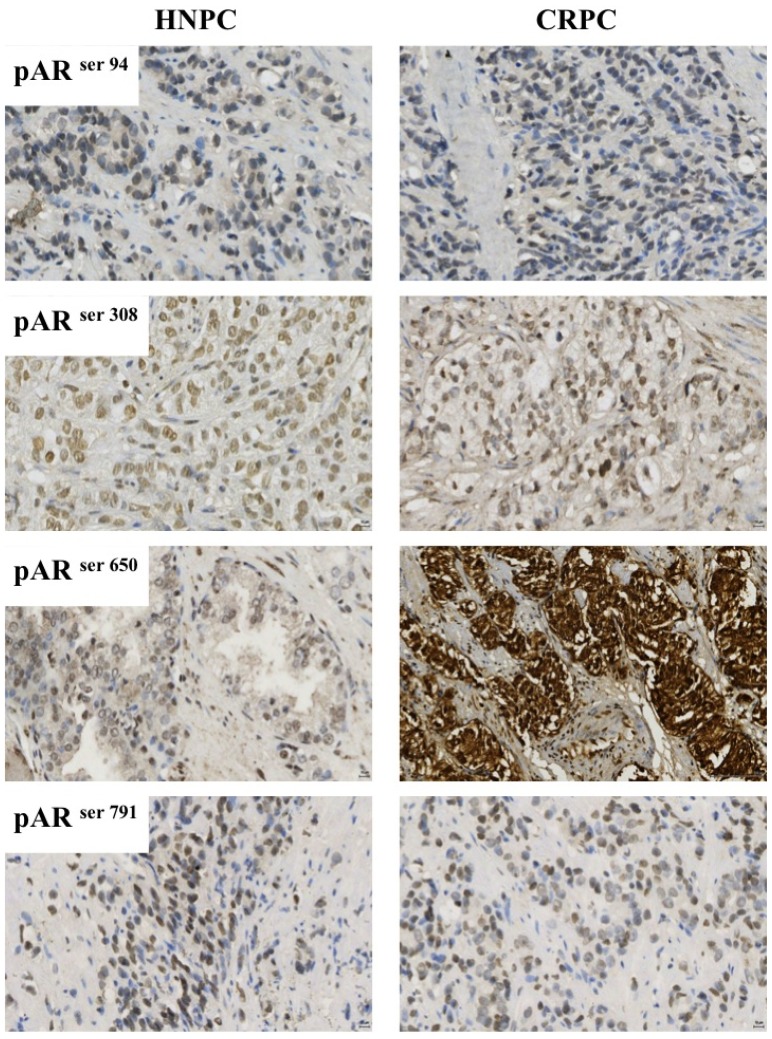
Prostate tumours displaying immunohistochemical staining of pAR94, pAR308, pAR650 and pAR791. The bar on each image represents 10 μm